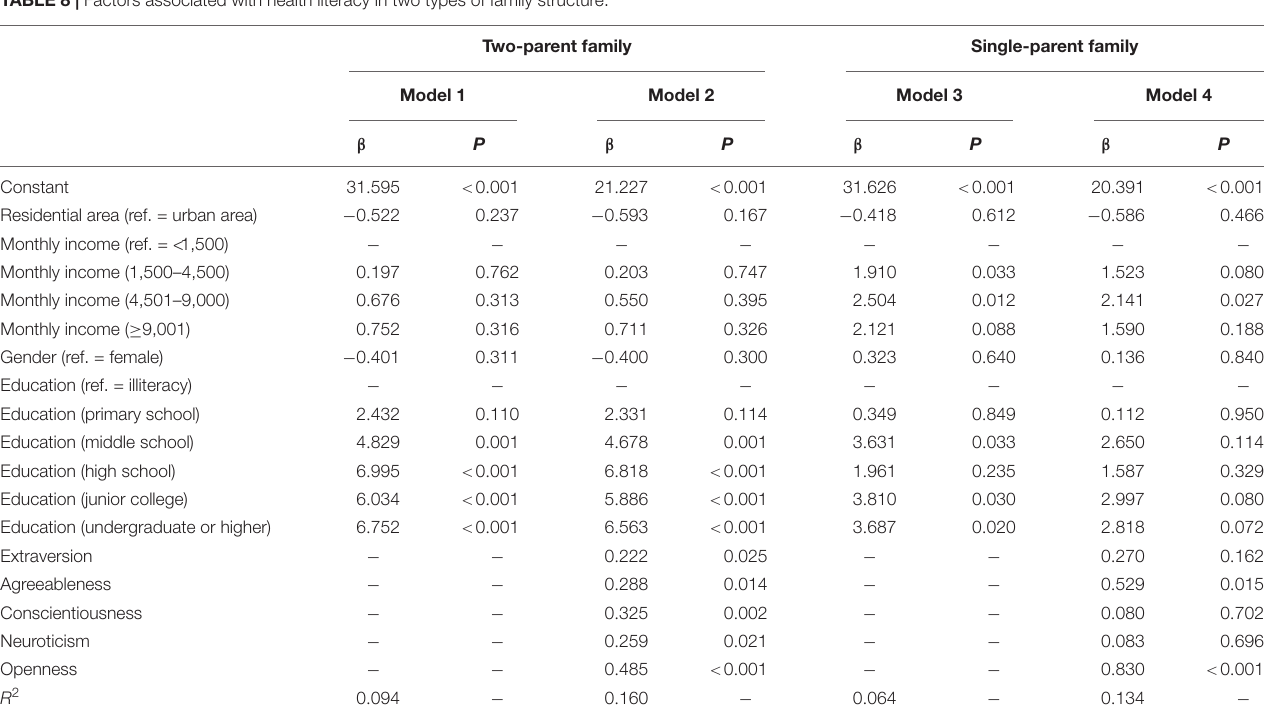
FIGURE 2 | Correlations between variables set of personality traits and variables set of health literacy and among their canonical variables in single-parent family. TABLE 8 | Factors associated with health literacy in two types of family